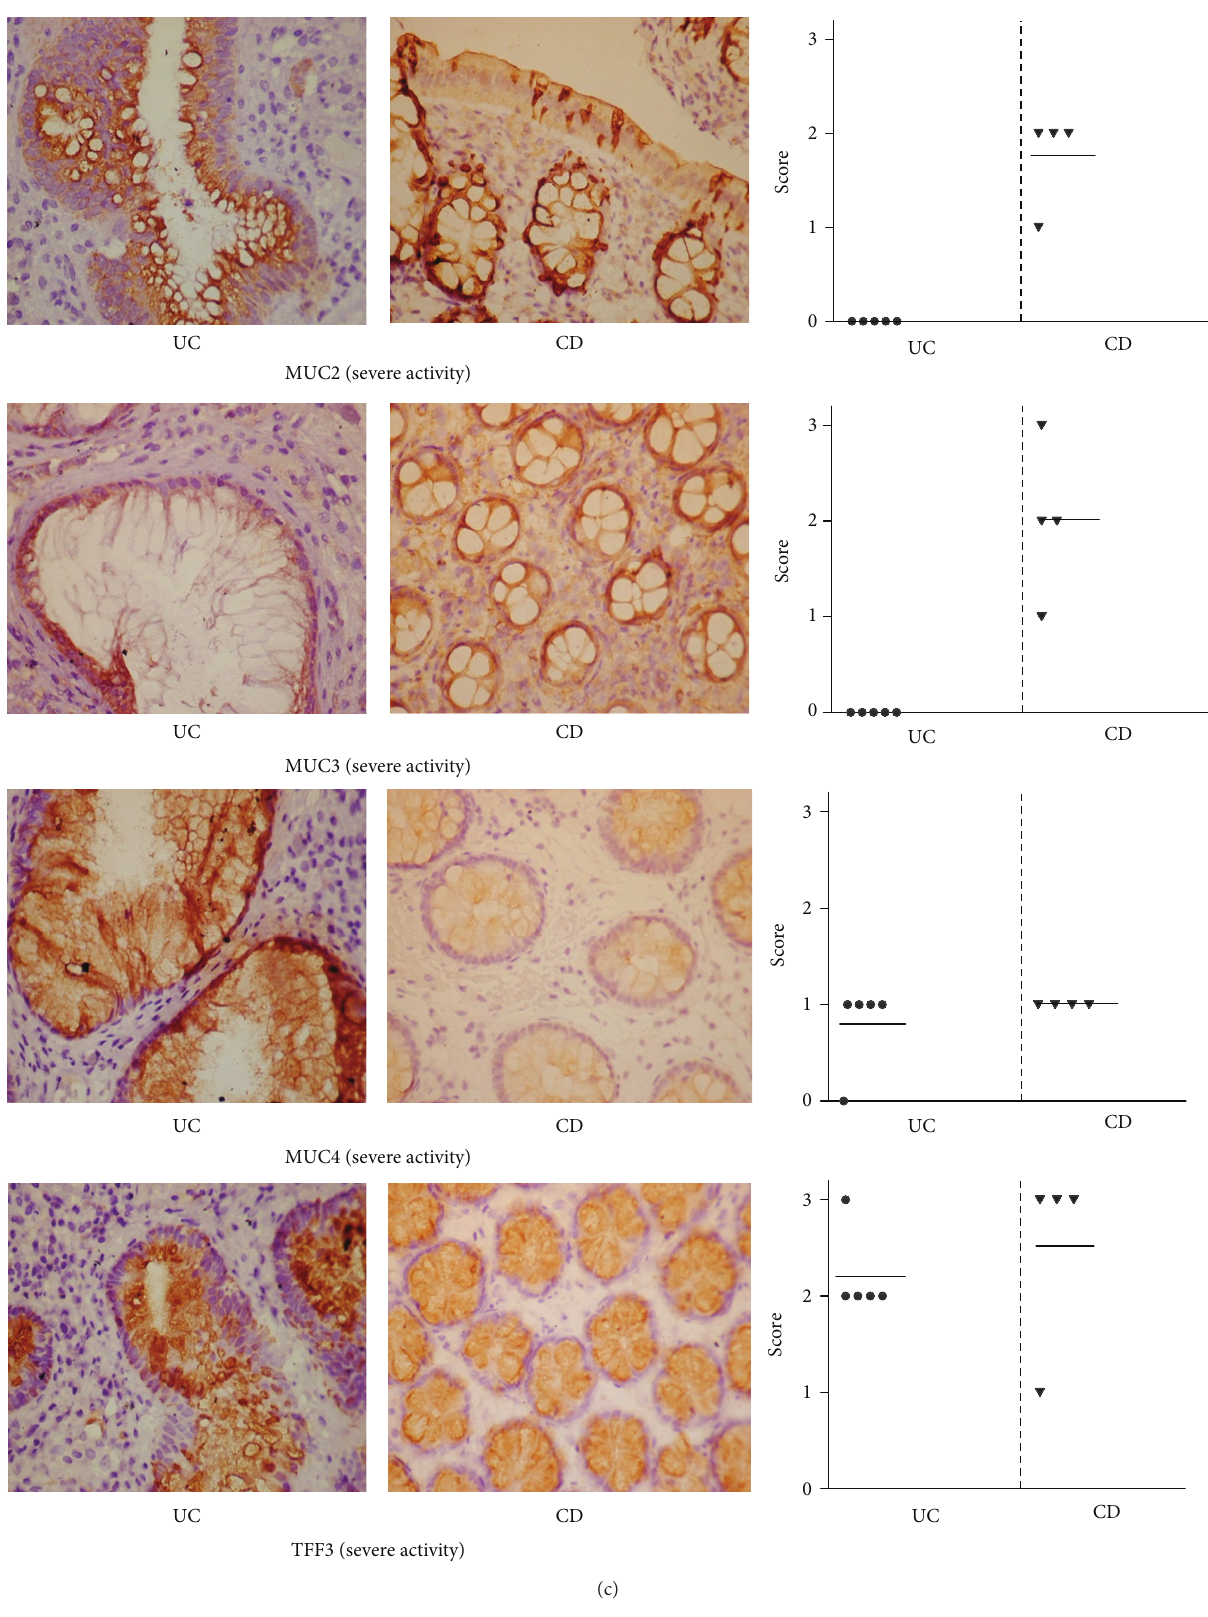
Figure 2: Mucins (MUC2-4) and TFF3 expression depending on severity of CD and UC. The apical surface of the large intestinal epithelium, crypts, goblet cells, and stromal epithelium are lined by the secretory mucin MUC2 and transmembrane MUC3, MUC4, and TFF3 (brown colored). Alcian blue (1.0 and 2.5) positive staining structures (blue, highly glycosylated; purple, medium glycosylated). The photographs are displayed in 400x